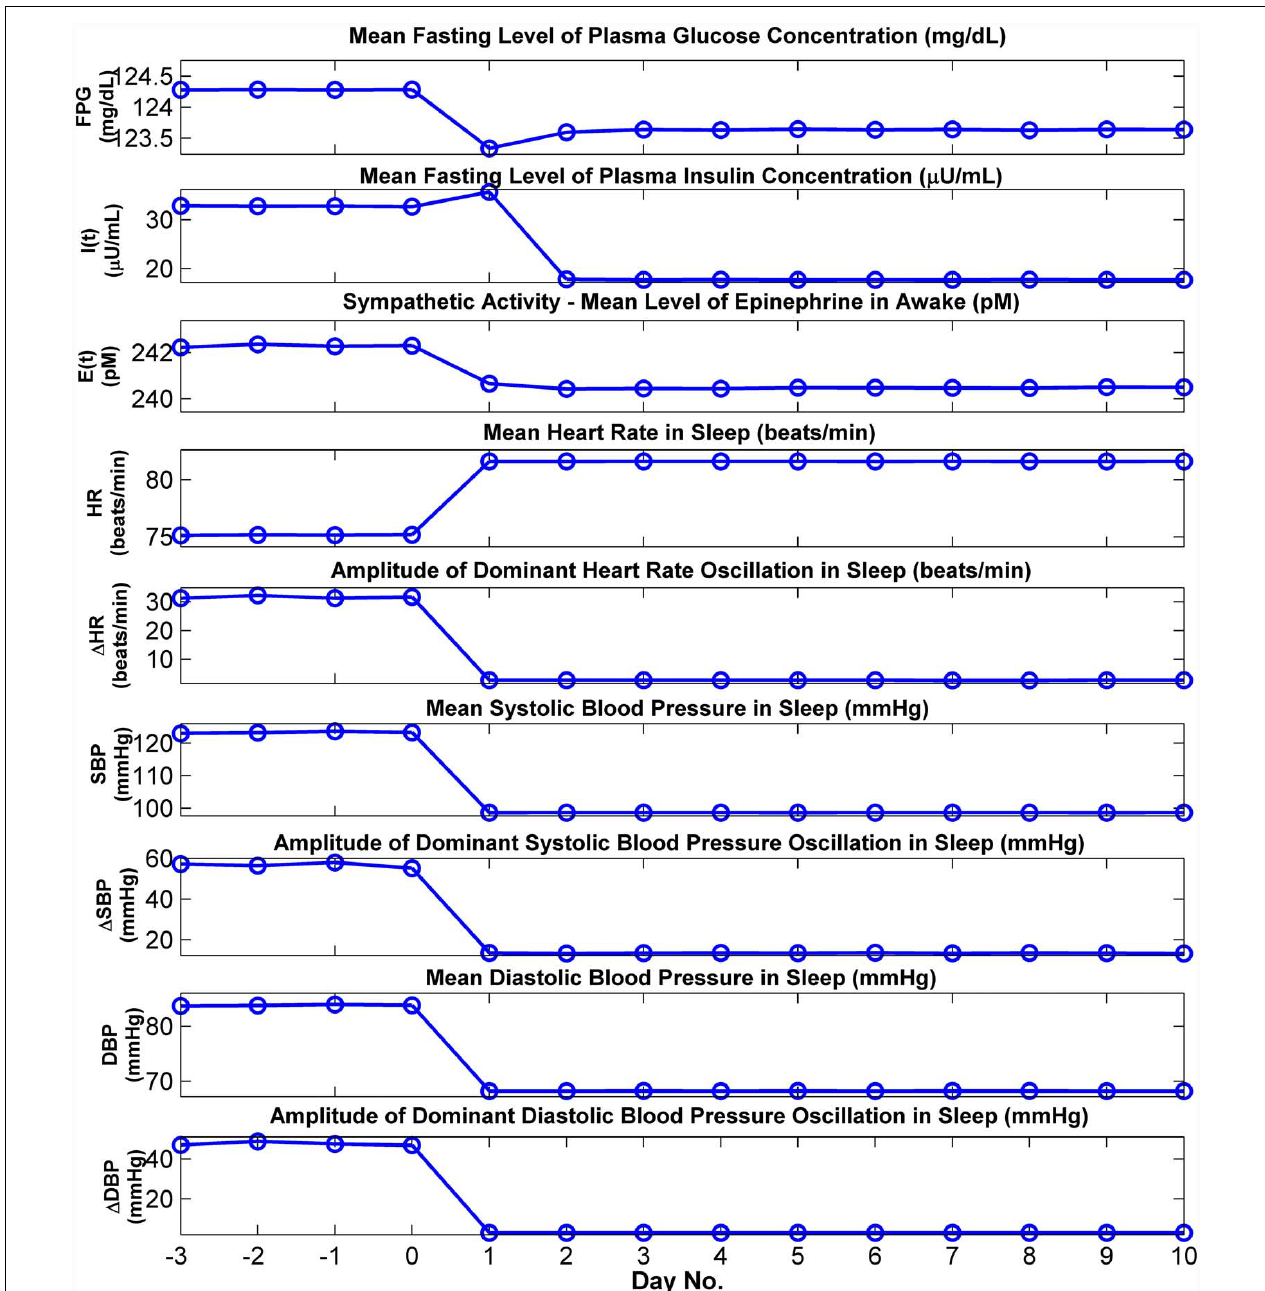
FIGURE 7 | Cardiovascular and metabolic responses predicted by model before and after the start of CPAP administration. In this simulation, the model is run in OSA mode until a steady state has been achieved, and at the end of “Day 0,” continuous positive airway pressure (CPAP) at 15cmH 2 O is applied. FPG and FPI: mean levels of plasma glucose and insulin, respectively, calculated from the 30min segment